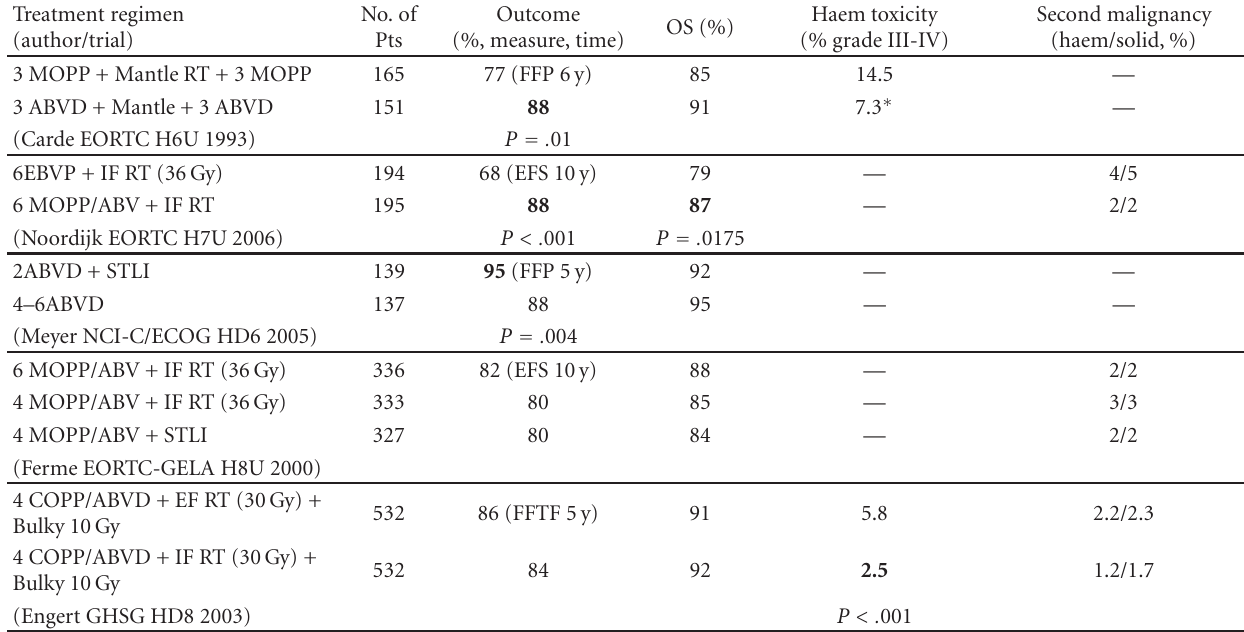
Table 4: Trials of treatments for early stage unfavourable Hodgkin’s lymphoma. Numbers in bold are statistically significant with P values where significant. ∗ Treatment discontinuation due to haematological intolerance. Abbreviations: OS: overall survival; EF RT: extended- field radiotherapy; IF-RT: involved-field radiotherapy; STLI: subtotal lymphoid irradiation; Gy: gray; ABVD: doxorubicin, bleomycin, vinblastine, and dacarbazine; EBVP: epirubicin, bleomycin, vinblastine, and prednisolone; MOPP/ABV: mechlorethamine, vincristine, procarbazine, prednisolone, doxorubicin, bleomycin, and vinblastine; COPP/ABVD: cyclophosphamide, vincristine, procarbazine, and prednisolone/ABVD; BEACOPP: bleomycin, etoposide, doxorubicin, cyclophosphamide, vincristine, procarbazine, and prednisolone.